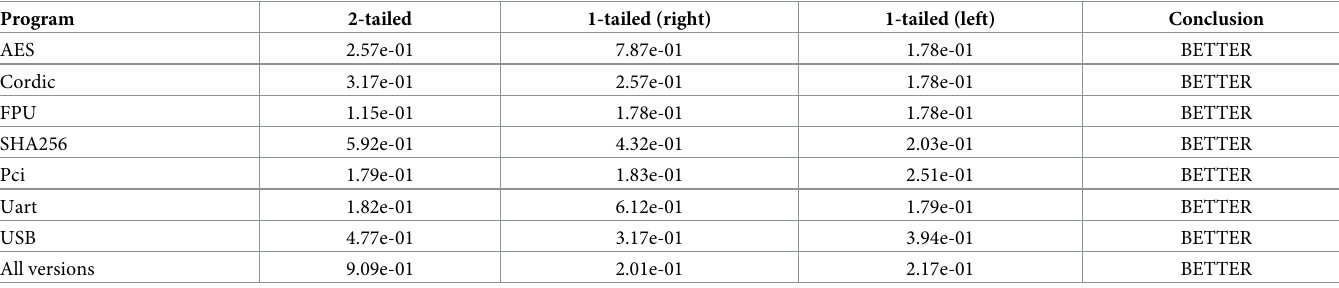
Table 6. Wilcoxon-Signed-Rank test of Detraque vs GDE.